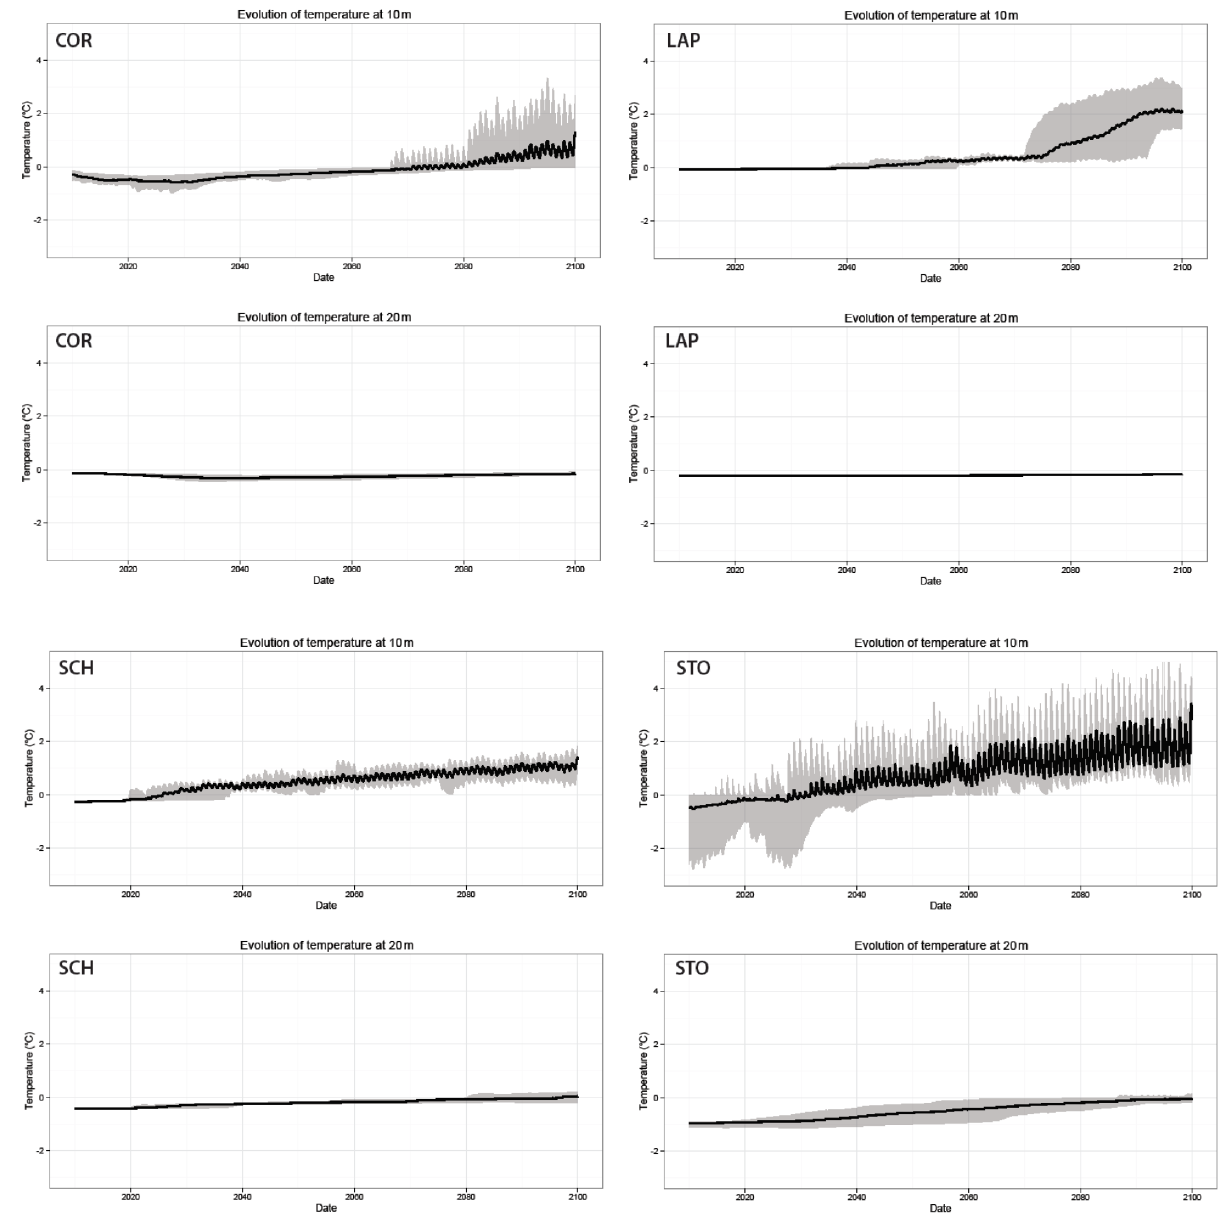
Figure 5. Modeled long-term evolution of ground temperatures at 10 and 20m at four different permafrost sites in the Swiss Alps (COR: Murtèl-Corvatsch, LAP: Lapires, SCH: Schilthorn, STO: Stockhorn), as simulated with the COUP model (Marmy et al., 2016). The black lines represent the median scenario and the gray zone the range of the 13 GCM/RCM chains which were used to drive the simulations. Modified after Marmy et al.